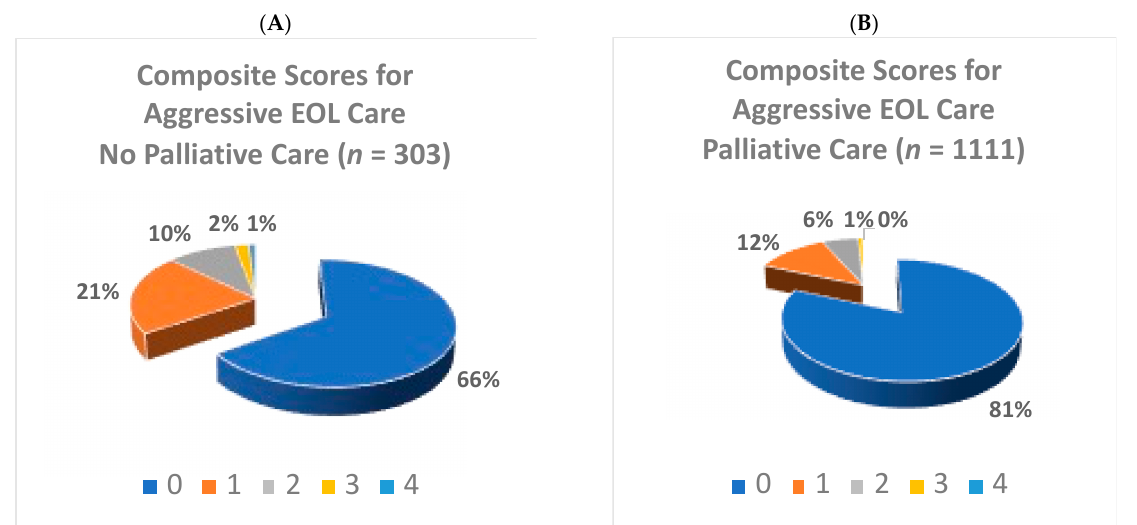
based on occurrence of palliative care (PC) consultation ( N = 1414).